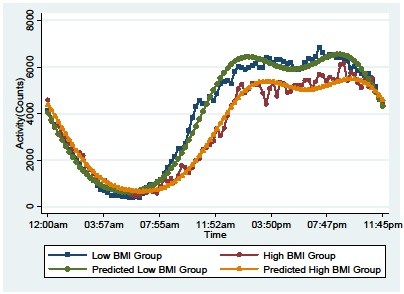
Activity plots for non-obese (BMI: 17.78kg / m2– 28.60kg / m2) and obese participants (BMI: 29.16kg / m2– 47.98kg / m2). Predicted means are estimated by the point-wise average of individual predicted means for each 15 minute interval.